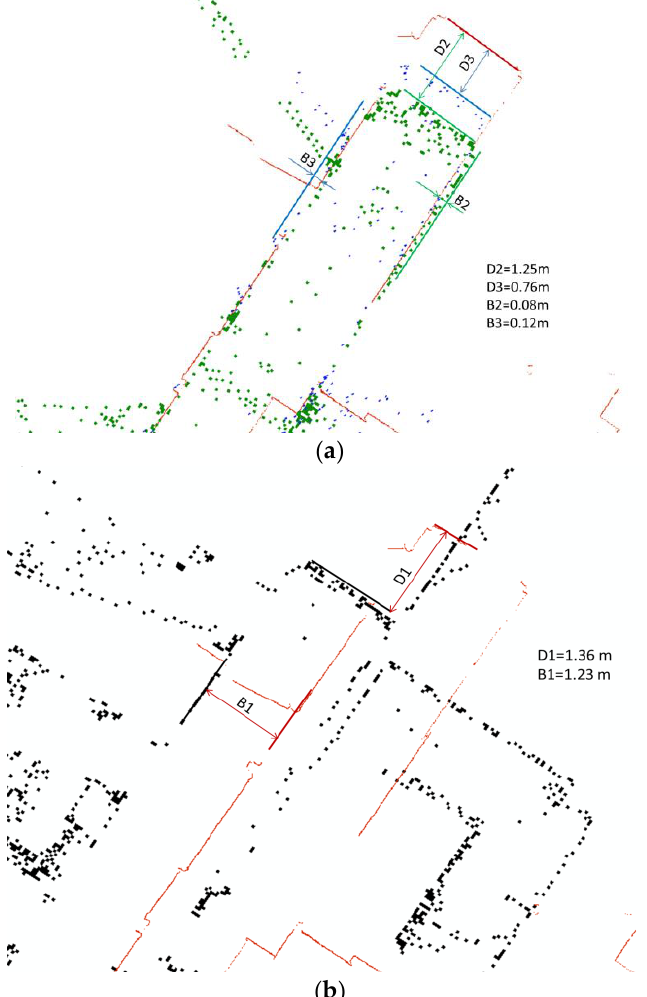
Table 4. Comparison of Matterport output with different mapping trajectory.